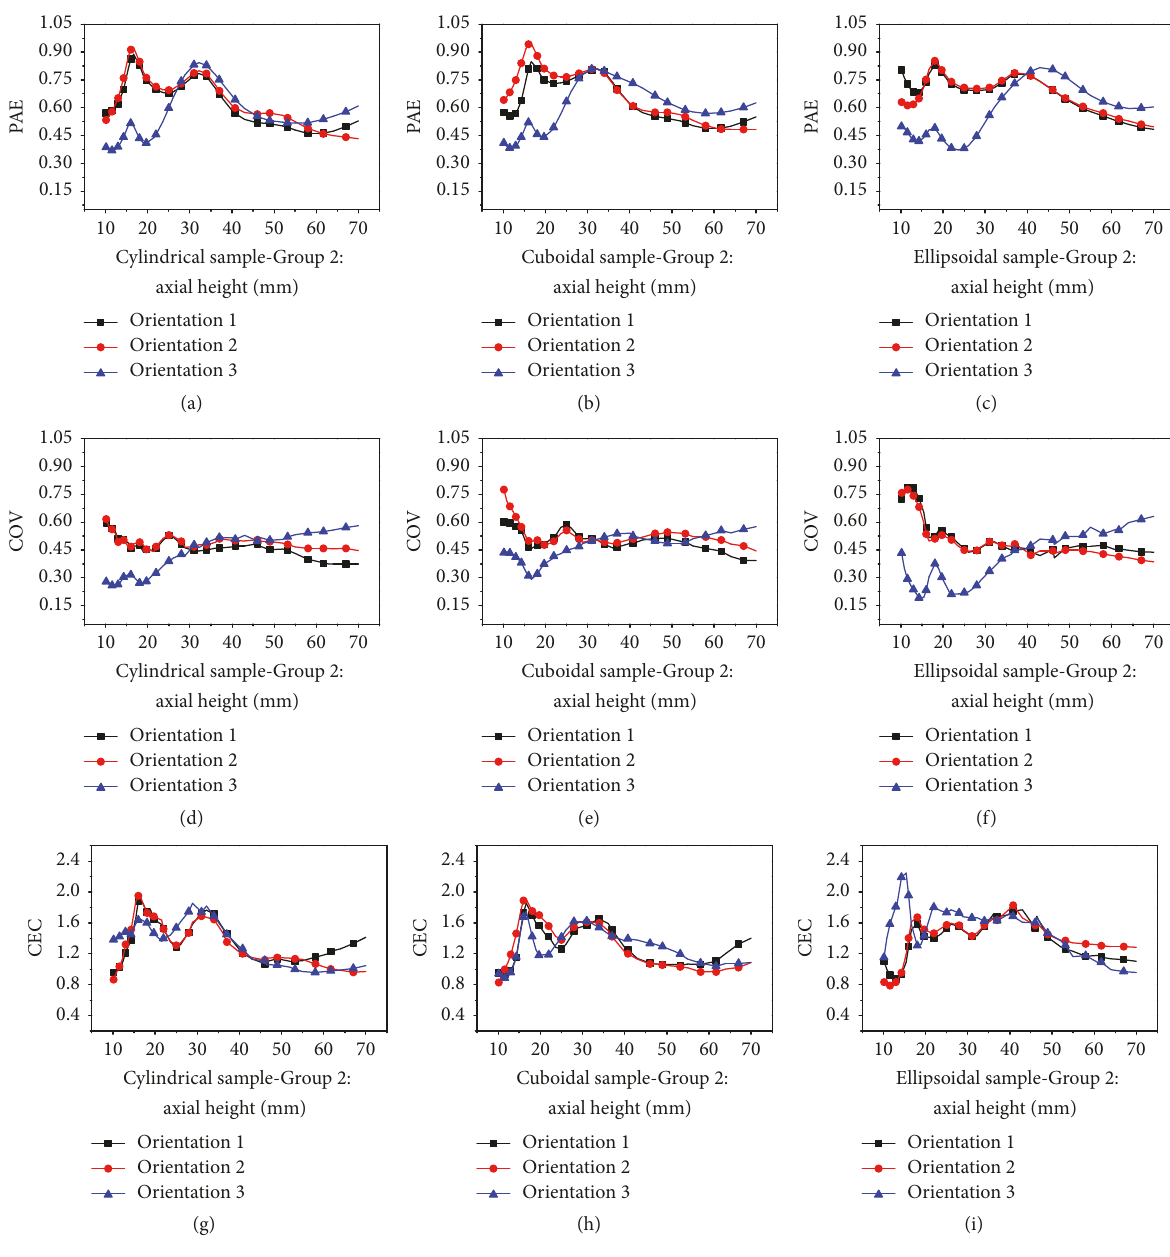
Figure 27: Same samples in different orientations, Group